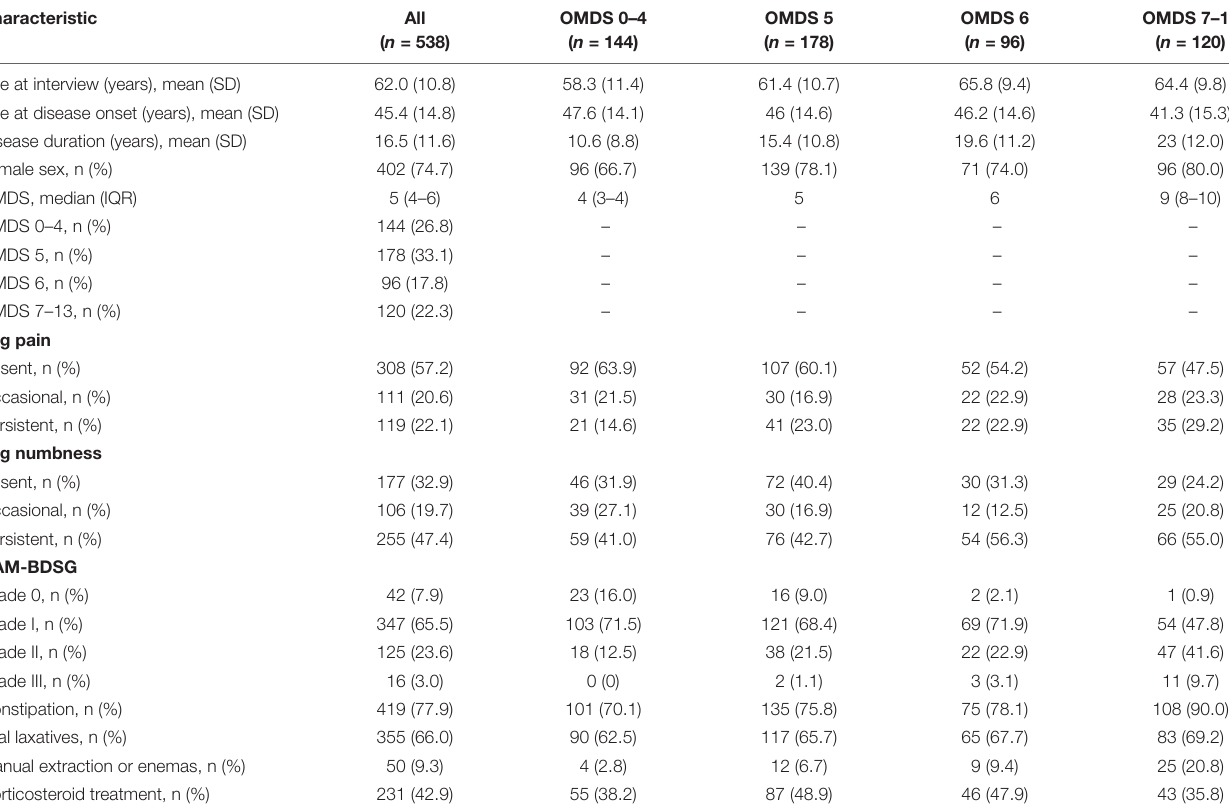
TABLE 2 | Patient